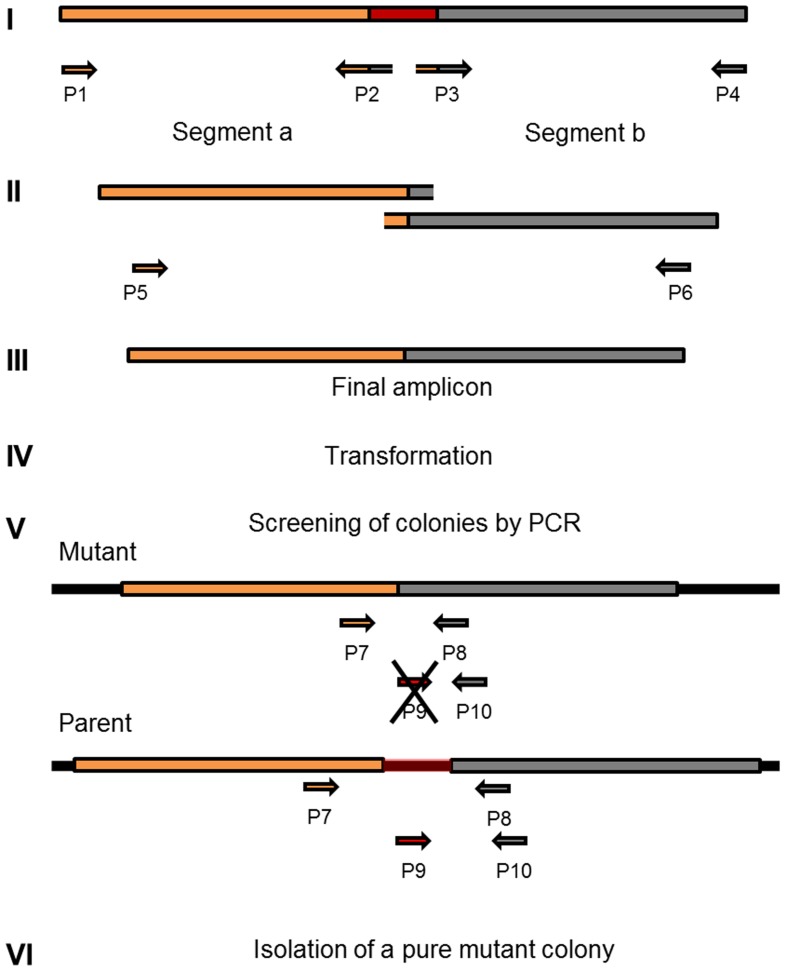
Workflow for markerless genome editing. Amplicon design and construction (I to III) are prepared according to the desired mutation, exemplified in this diagram as a gene deletion (marked in red). This step is followed by a highly efficient (>10%) method for natural transformation (IV). Two dozen colonies recovered from the transformation step are screened with specific primers that amplify fragments with different sizes in the mutant when compared to the parent (V). Isolation of colonies with only the new recombined chromosomal DNA (VI).